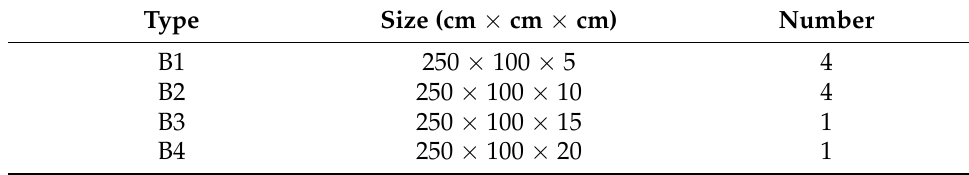
Figure 5. Specimens casting. Table 2. Type and size of concrete slab.